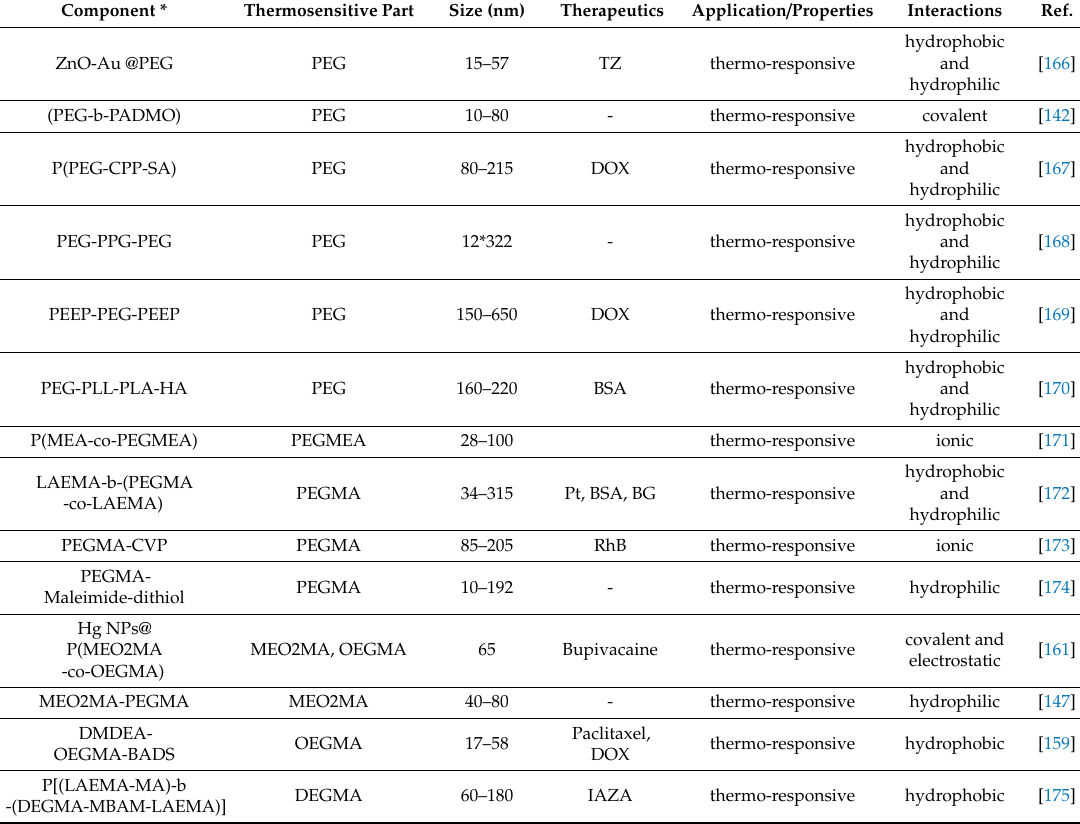
Table 2. Components and applications of investigated thermosensitive nanogels containing polymers bearing vinyl ether groups. ”-“means there is no therapeutic agent introduced in the reference paper and only thermosensitive drug carrier was synthesized and prepared.